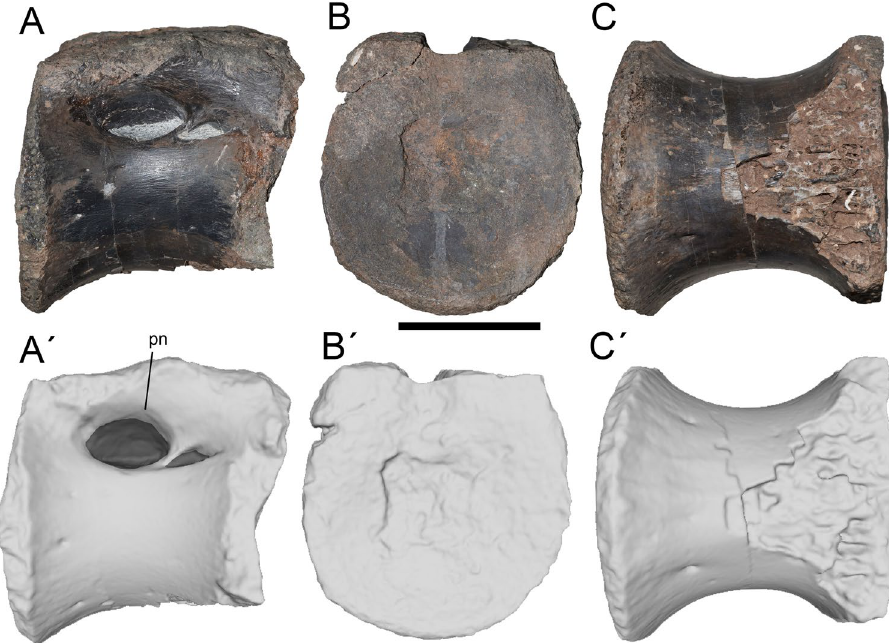
Figure 8. Tenth or eleventh dorsal of Maip . Lateral ( A, A´ ), anterior ( B, B´ ) and ventral ( C, C´ ) views. Scale bar: 5 cm. Abbreviations: pn,